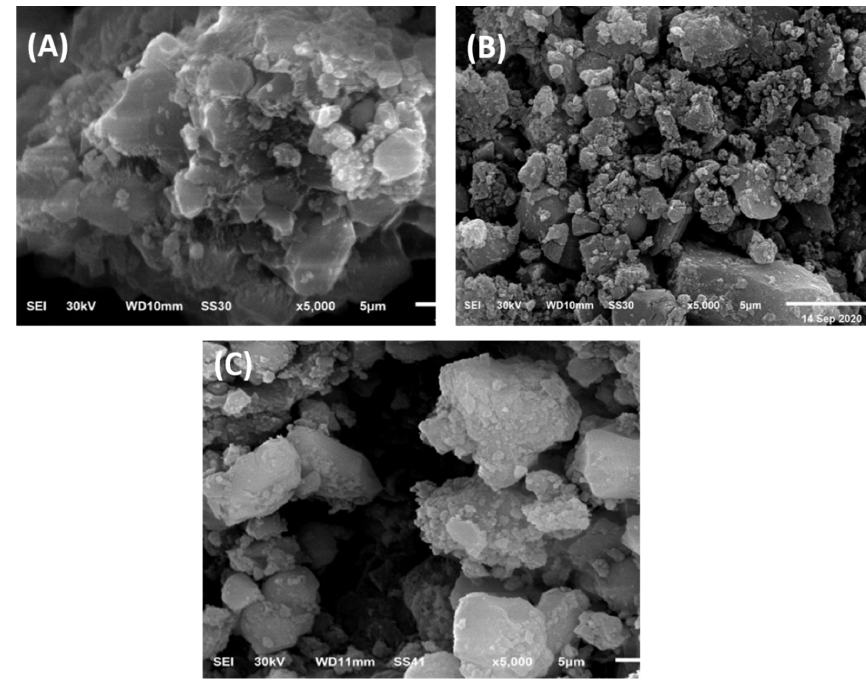
Figure 2. SEM of ( A ) NLS/Cs/Alg., ( B ) NLS/Cs/Alg.–CR dye, and ( C ) NLS/Cs/Alg.–BG dye.